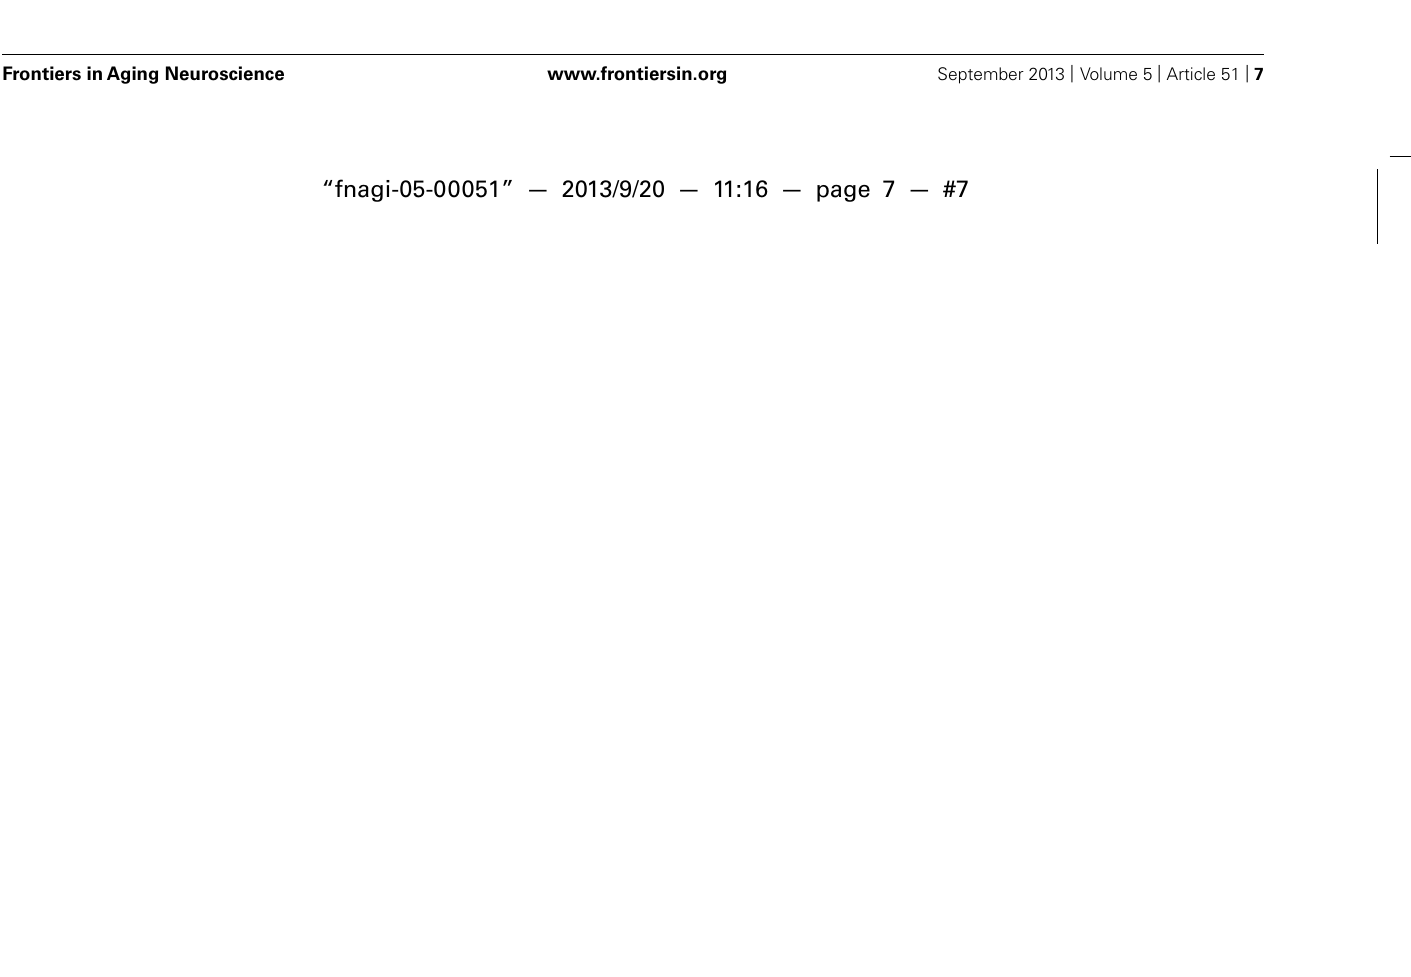
FIGURE 2 | Results of the event-related potential analysis of the right anterior region of interest (electrodes F4, F6, FC4, FC6; not displayed are F2, FC2) . Waveforms are shown in panel (A) . Solid lines indicate the ERPs of controls, dotted lines mark ERPs of patients. Hits are given in red